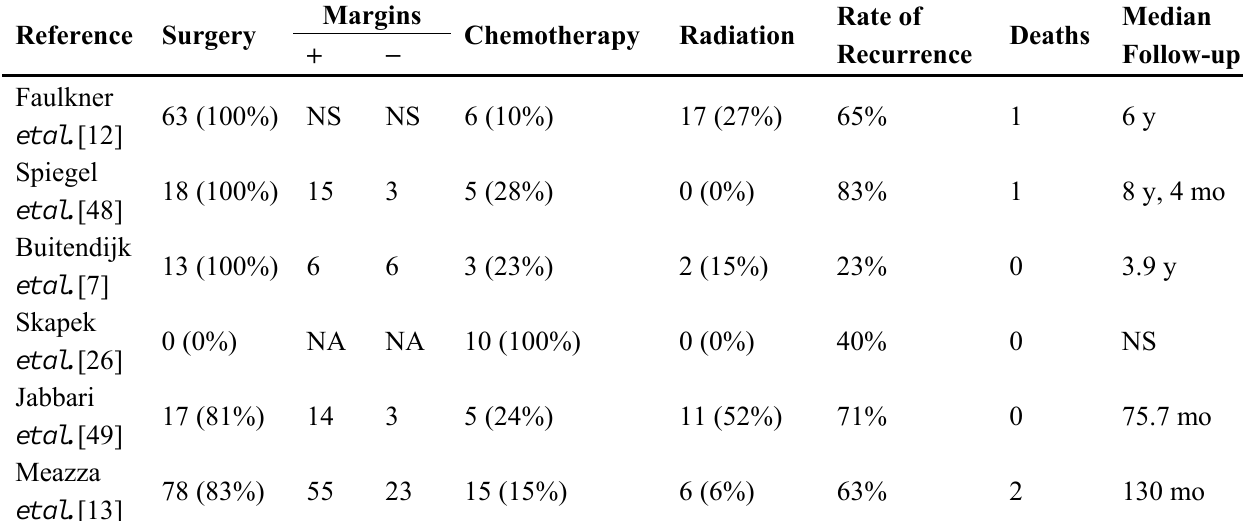
Table 2. Literature review: Treatment and